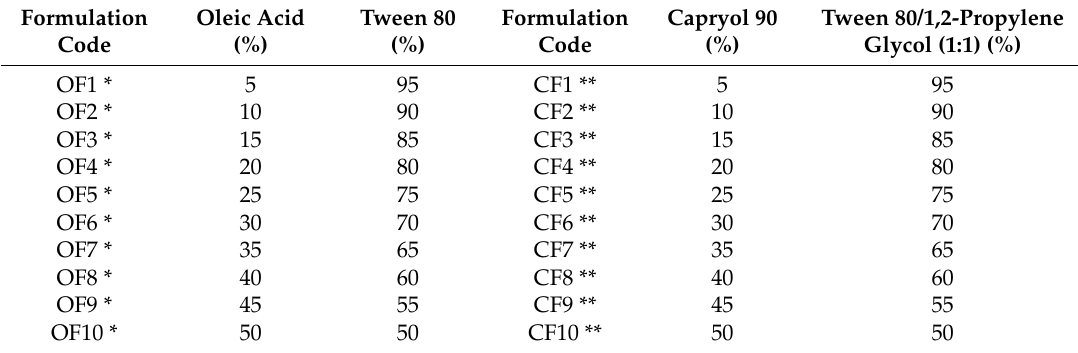
Table 2. Composition of liquid atorvastatin-SEDDS. In all the formulations the amount of atorvastatin was constant (10